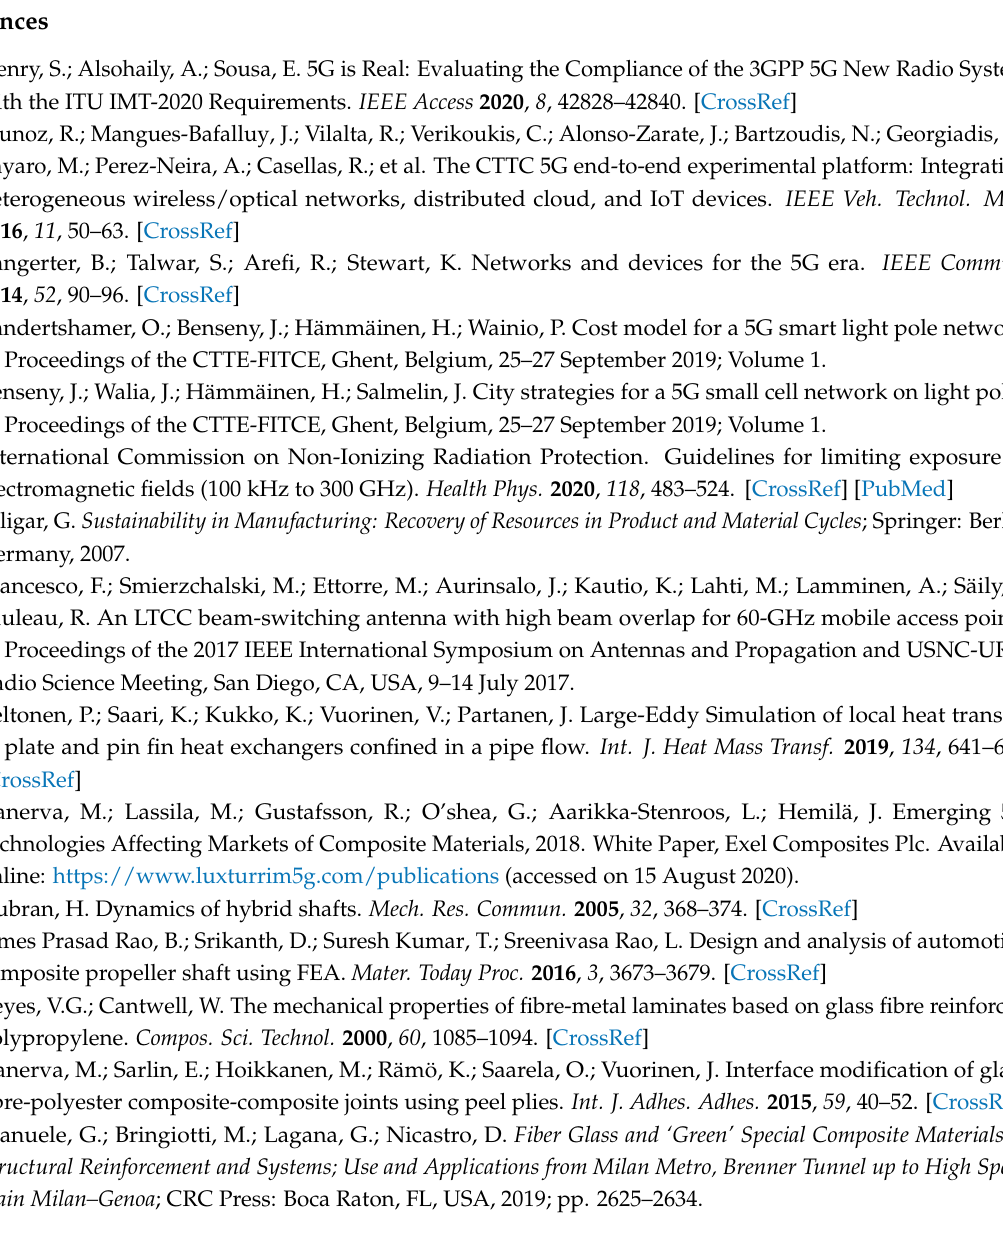
Figure A2. Technical drawing of the heat exchanger. Dimensions are in